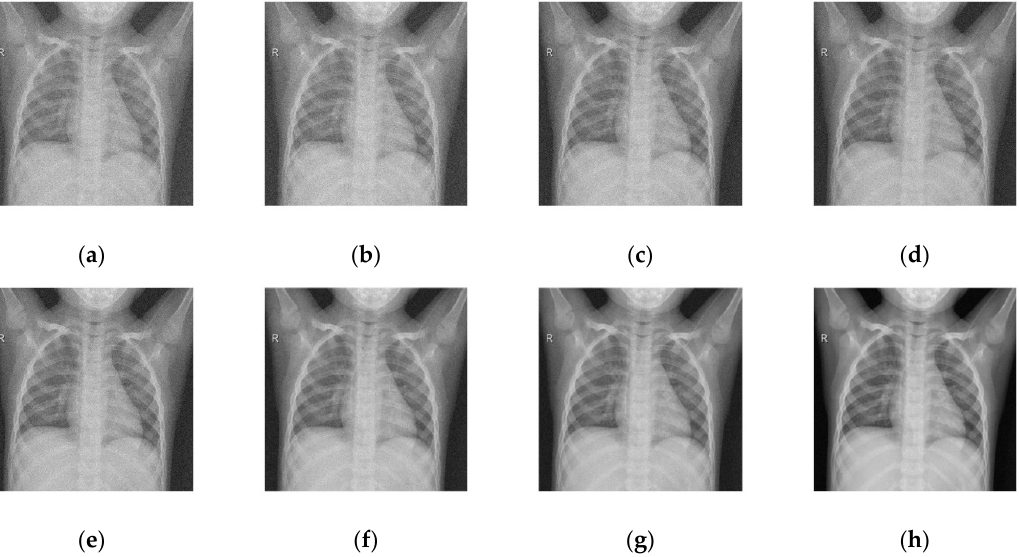
Figure 4. Denoised COVID ‐ 19 CT image 1 from the ( a ) [10], ( b ) [11], ( c ) [12], ( d ) [13], ( e ) [14], ( f ) [11], ( g ) [16], and ( h ) proposed frameworks, respectively.